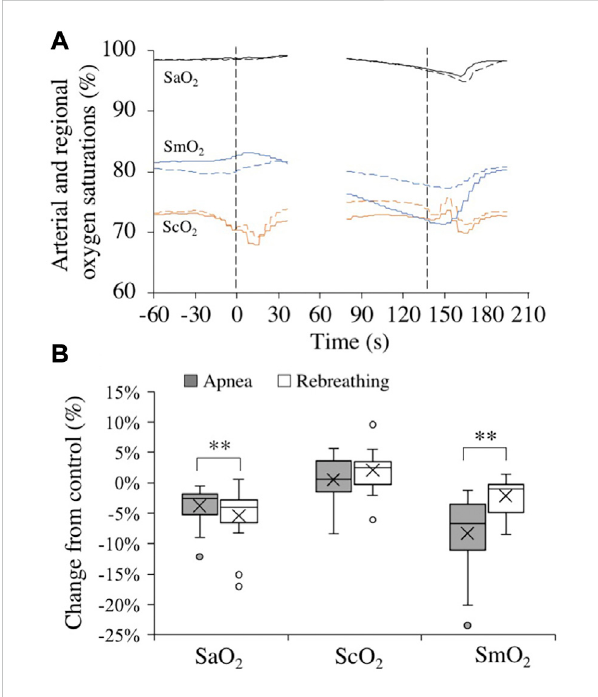
FIGURE 4 Changes in arterial (black, SaO 2 , n = 18), cerebral (orange, ScO 2 , n = 17) oxygen saturations in n = 18), and deltoid muscle (blue, SmO 2 , association with apneas (solid lines) and rebreathing periods (dashed lines). Panel 4 (A) shows the means of each variable from before, during, and after tests (see fi gure legend 3 for details). Panel 4 (B) showsboxplotsfortherelativechangesineachvariableatnadir(SaO 2 ) or during 20 – 10 s before the end of apneas and rebreathing periods (ScO 2 and SmO 2 ) compared to their respective control value (see fi gurelegend2for details).** p <